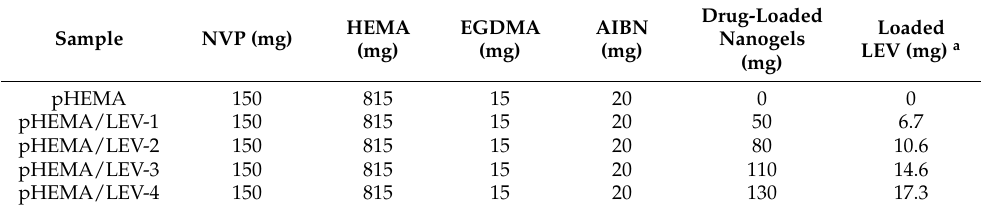
Table 2. The formulas for the series of nanogel-embedded contact